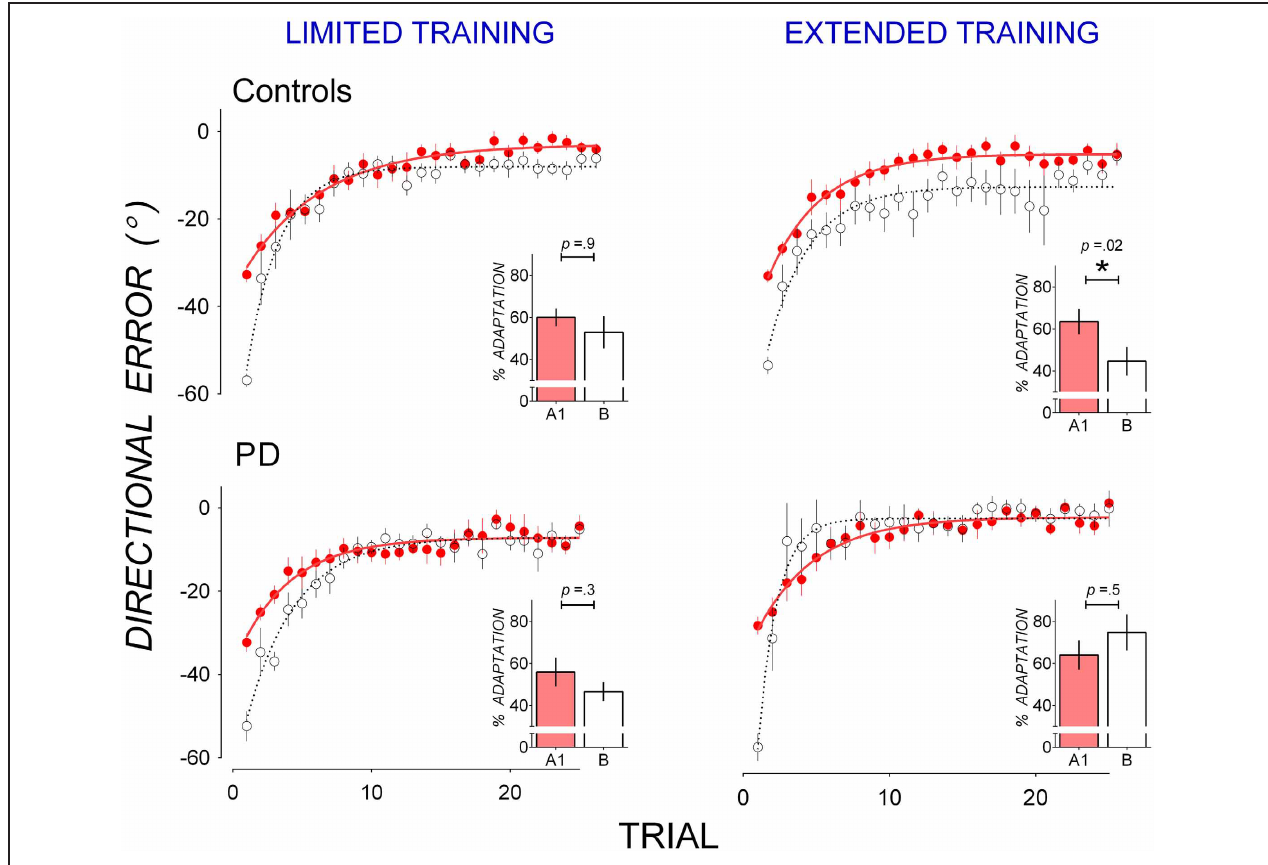
FIGURE 3 | Mean trial-by-trial directional error in A1 (closed, red circles) and B (open circles) in controls (top panels) and PD (bottom panels) for the limited training condition (left panels) and the extended training condition (right panels). A single-exponential function was fit to